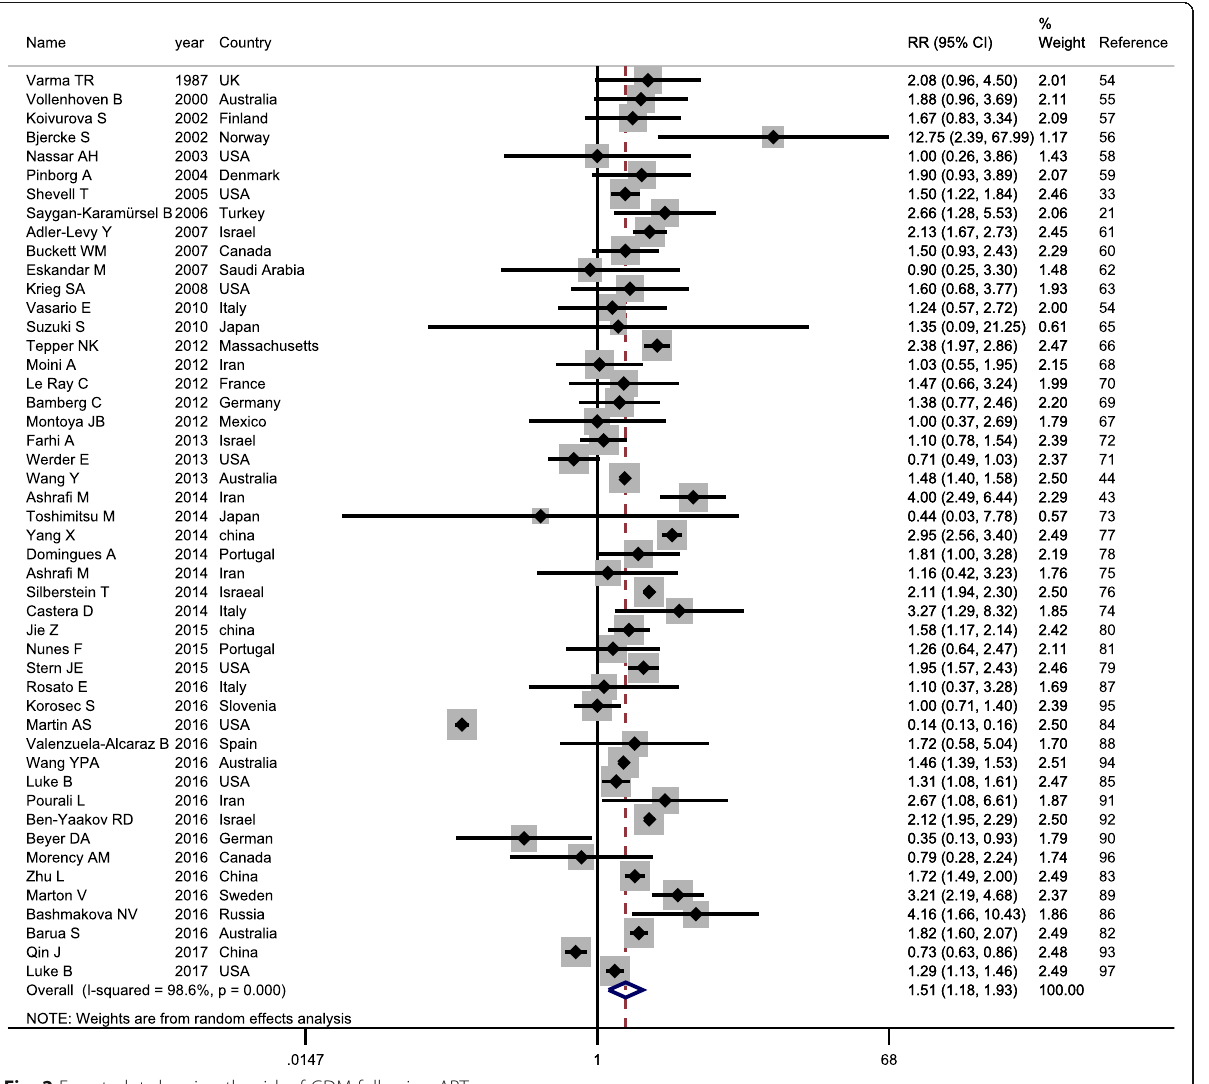
Fig. 2 Forest plot showing the risk of GDM following